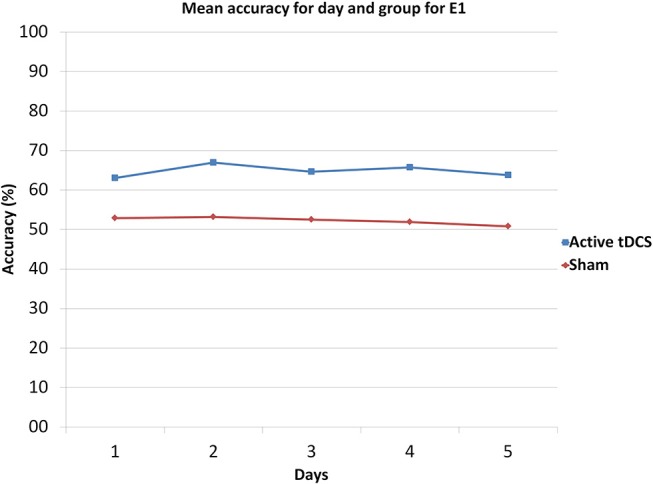
Mean accuracy for each day and group in E1.